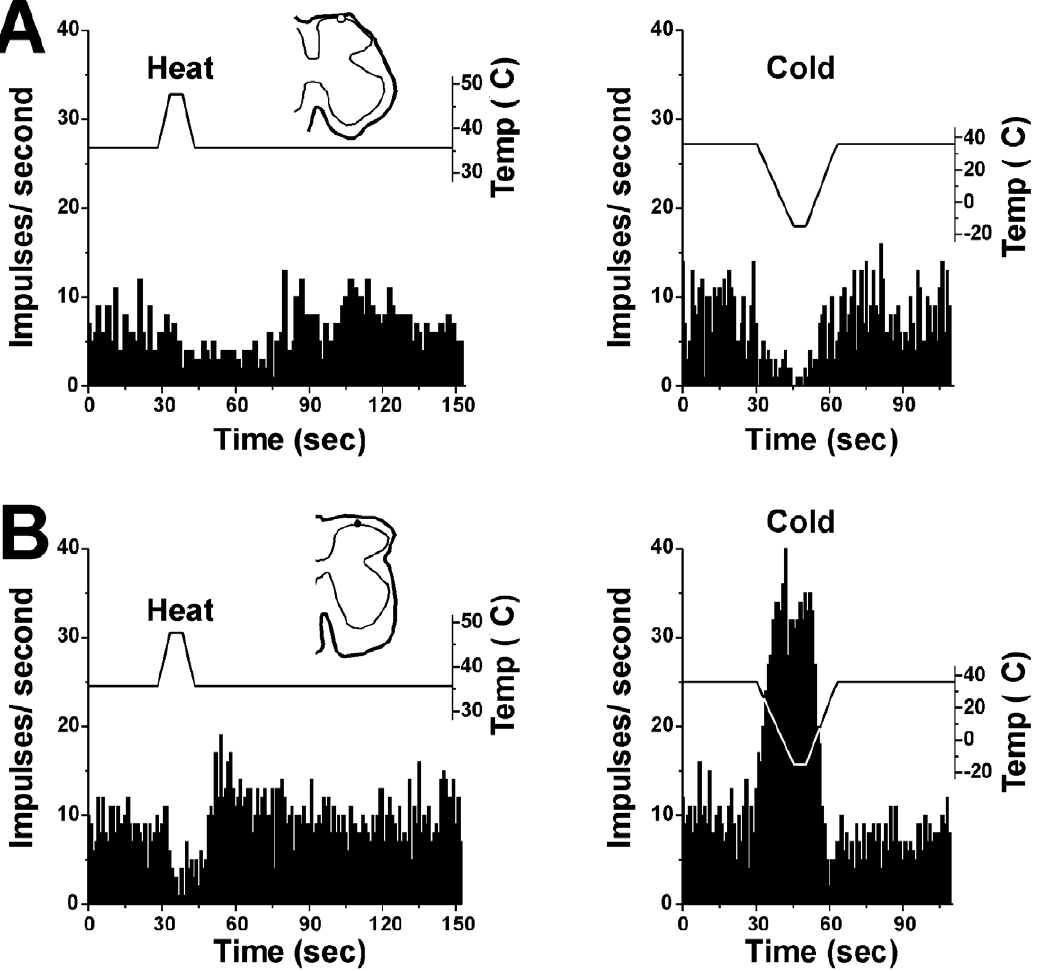
Figure 3. Effects of heat and cooling on spinal neuronal firing. A: PSTHs (bins: 1 sec) showing response of a superficial dorsal horn unit to thermal stimulus. Left top panel shows 48 u C heat-evoked depression of firing. Right top panel shows 2 5 u C cold-evoked depression of firing. Bottom graph shows temperature. B: PSTH showing response of different unit in A to thermal stimuli. Left panel: 48 u C heat stimulus depressed firing. Right panel shows 2 5 u C cold-evoked enhancement of firing. Traces above PSTHs show temperature.